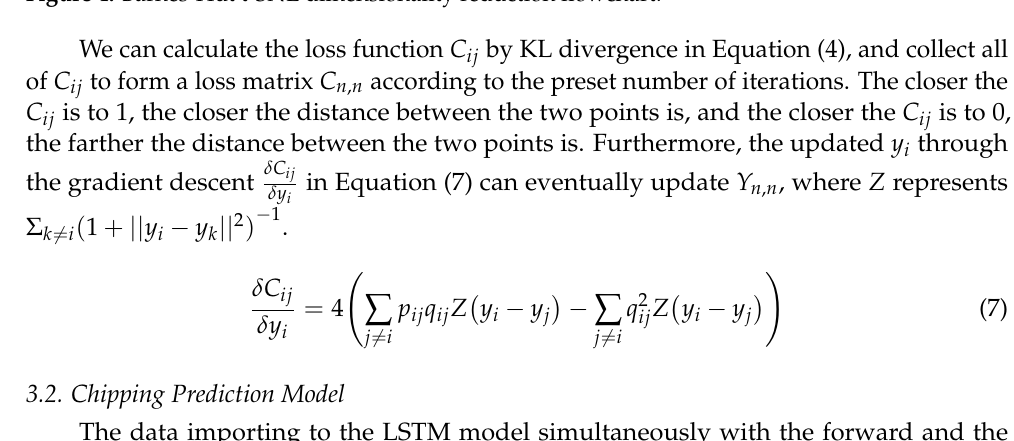
Figure 4. Barnes-Hut t-SNE dimensionality reduction flowchart.